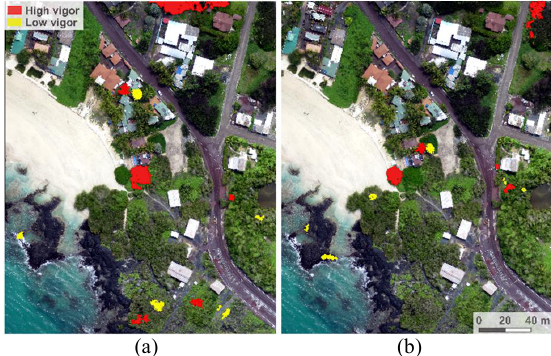
Figure 4. Labeled segments. (a) Training segments (a), and (b) validation segments